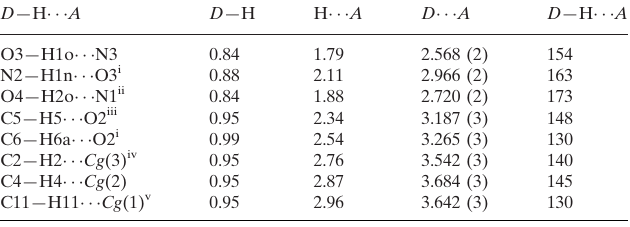
Hydrogen-bond geometry (A˚ , (cid:3)